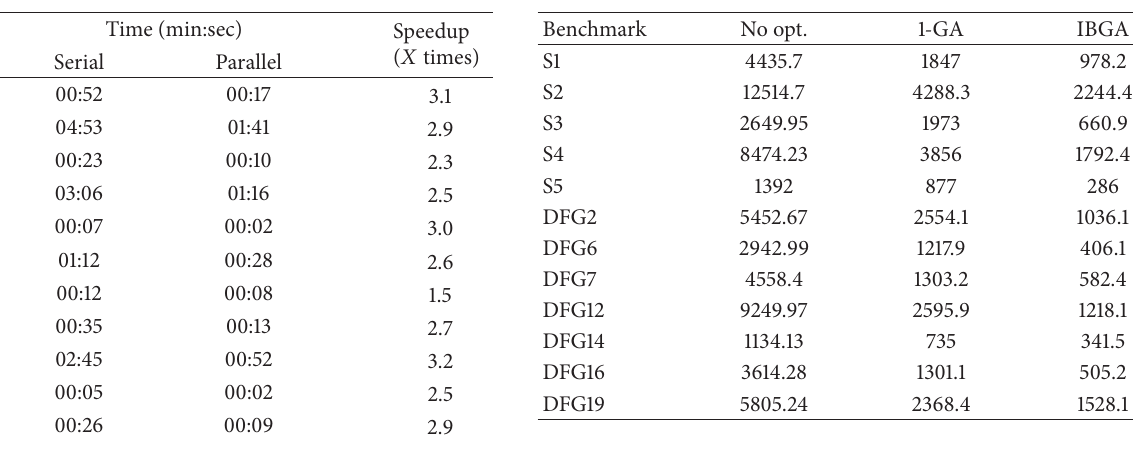
Table 11: IBGA run-time for serial and parallel implementation. Table 12: The average of 10 runs for the best fitness